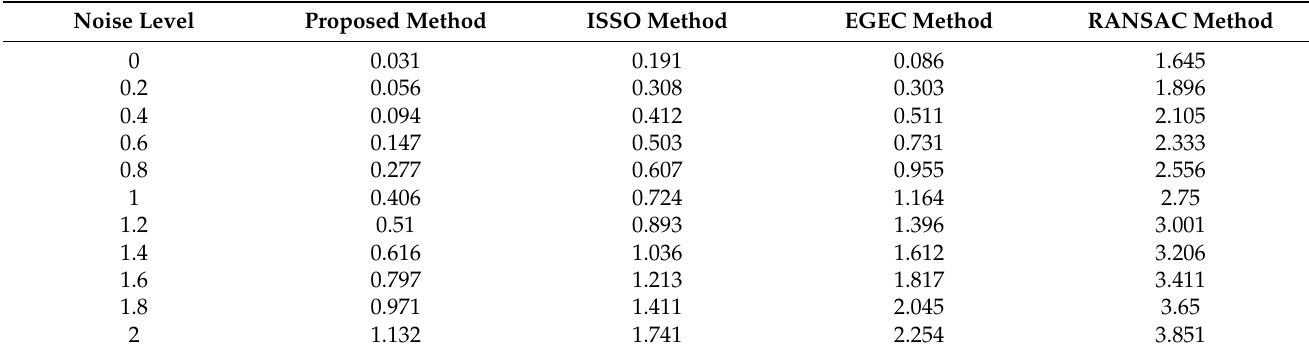
Figure 6. Comparisons of the distance between intersection points and feature points. ( a ) The mean distance with varying Gaussian noise; ( b ) The mean distance with varying outliers proportion. Table 1. The mean epipolar geometric distance of synthetic data (pixel).